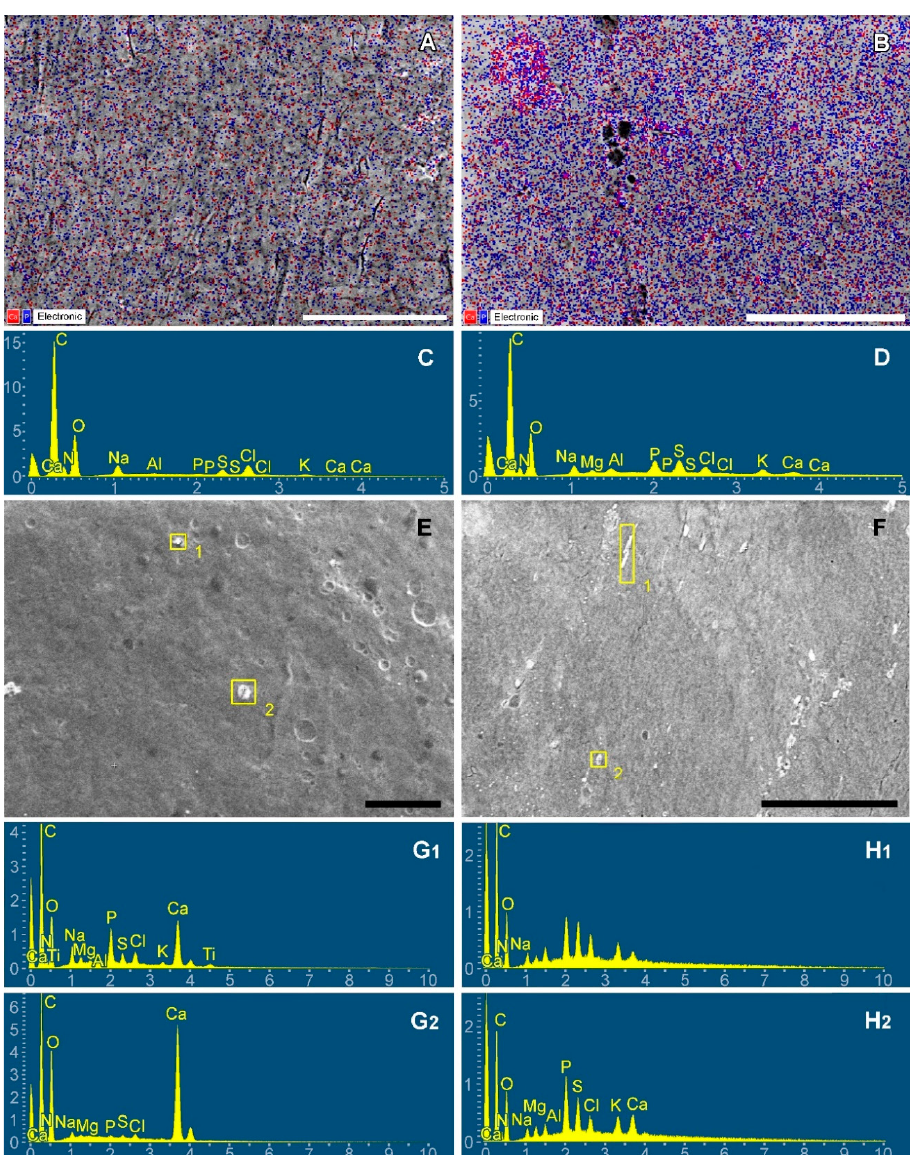
Figure 9. Ca (red) and P (blue) mapping of dry subcutaneous fascia excised from adult ( A ) and young ( B ) rats; EDS spectra of subsequent maps ( C , D ); calcium is visualized with red dots, phosphorus with blue ones. Electron-dense particles on the fascial surfaces: adult ( E ) and young ( F ) rats; spectra corresponding to particles 1 and 2 of each image ( G , H ). Scale bars 100 µm.